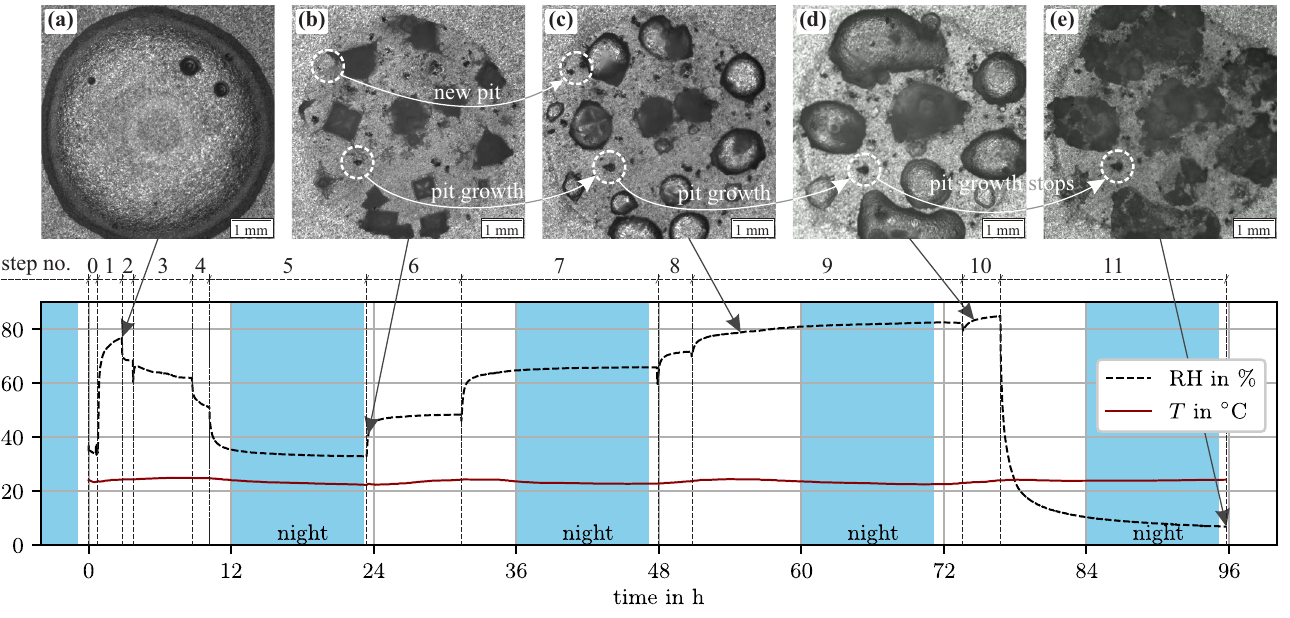
Figure 5. Relative humidity (RH) and temperature T during the atmospheric corrosion experiment, and exemplary images ( a – e ) of the deposited droplet and the corroded surface. The areas marked in blue represent the night times from 8pm to 7am.